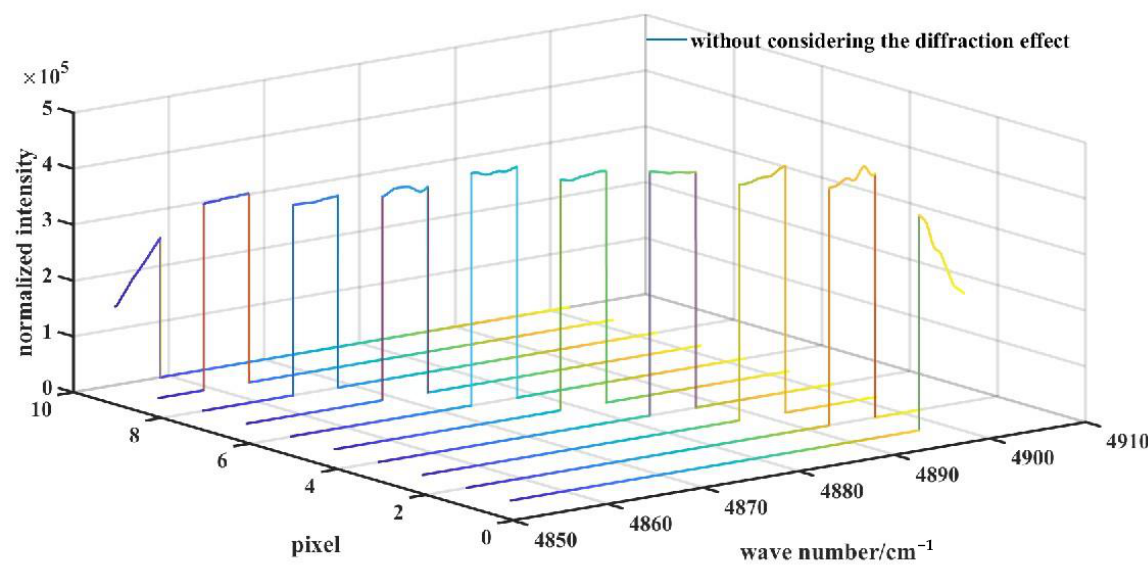
Figure 12. Recovered spectra of each pixel, without considering the diffraction effect.